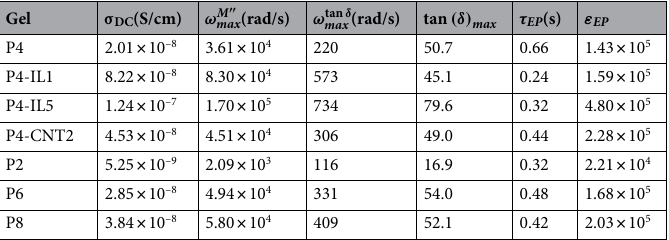
Table 2. A summary of electric properties of PVC gel